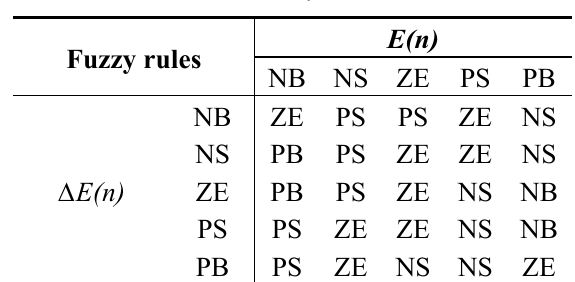
Table 2. Fuzzy rule table.